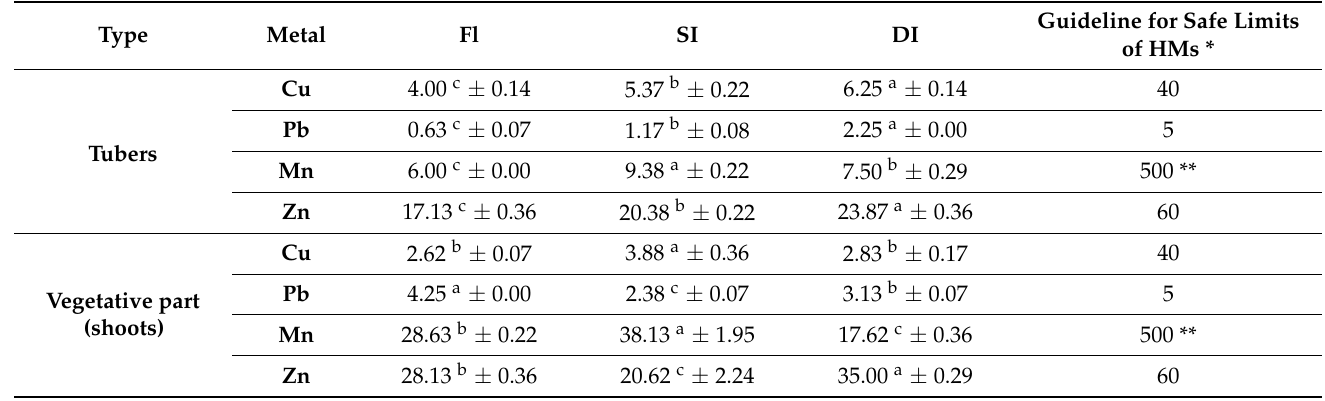
Figure 5. HM concentrations (mean ± SE; mg/kg soil) in soil profile under different irrigation methods; ( a ) Cu, ( b ) Mn, ( c ) Pb, and ( d ) Zn. Small letters show significant difference between different irrigation methods. Bars with the same letters for the same location refer to insignificant difference and bars with different letters for the same location refer to the existence of significant difference at p -level < 0.05 according to Duncan’s multiple range test. Table 7. Concentrations of HMs in plant (mean + SE; mg/kg) under FI, SI, and DI methods with water containing